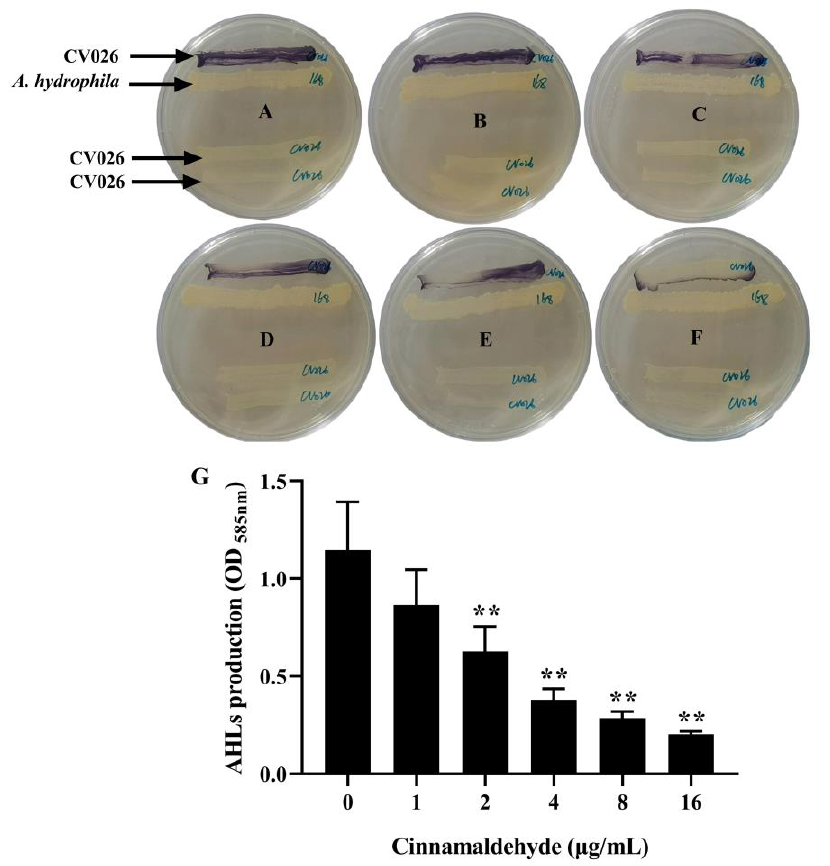
Figure 6. Cinnamaldehyde reduces AHLs production by A. hydrophila . ( A ) Cinnamaldehyde-free group; ( B ) 1 μg/mL; ( C ) 2 μg/mL; ( D ) 4 μg/mL; ( E ) 8 μg/mL; ( F ) 16 μg/mL; ( G ) violacein production of C. violaceum CV026 in response to AHLs at indicated cinnamaldehyde concentrations, all data are the mean ± SD of three independent experiments. **, p < 0.01 when compared to the drug-free group.